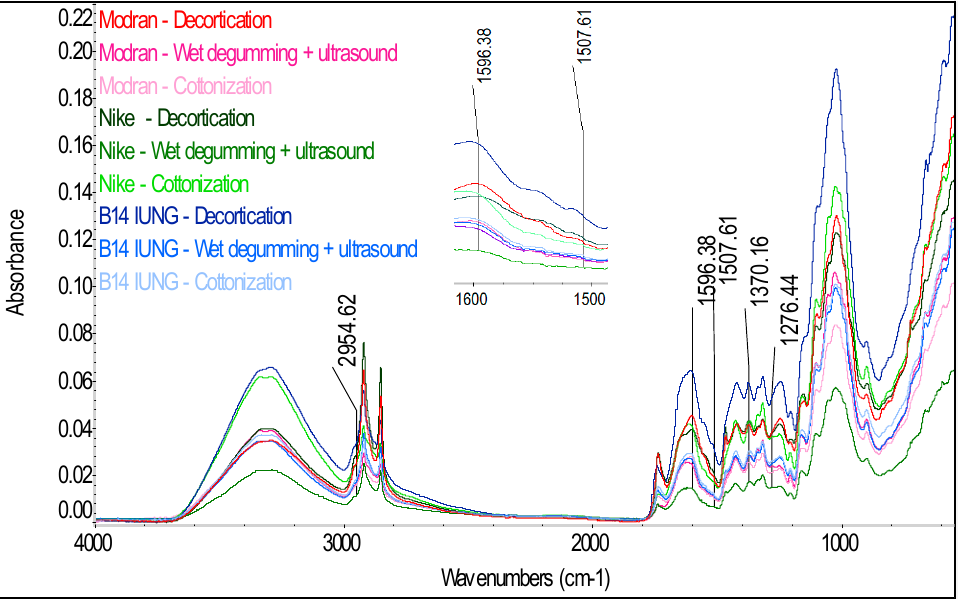
Figure 7. The Fourier transform infrared Attenuated Total Reflection spectra of the flax fibers of Modran, Nike and B14 IUNG variety after technological processes.